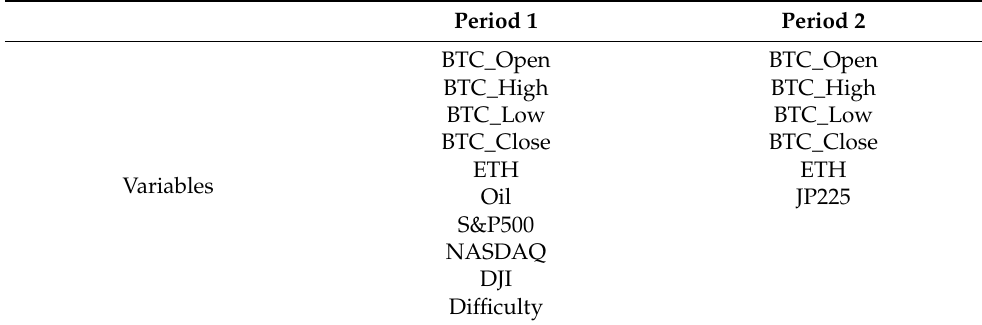
Table 7. Explanatory variables used in Period 1 and Period 2.